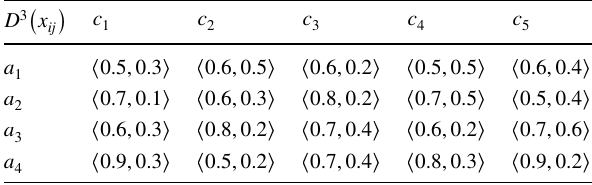
Table 6 Pythagorean fuzzy matrix given by expert